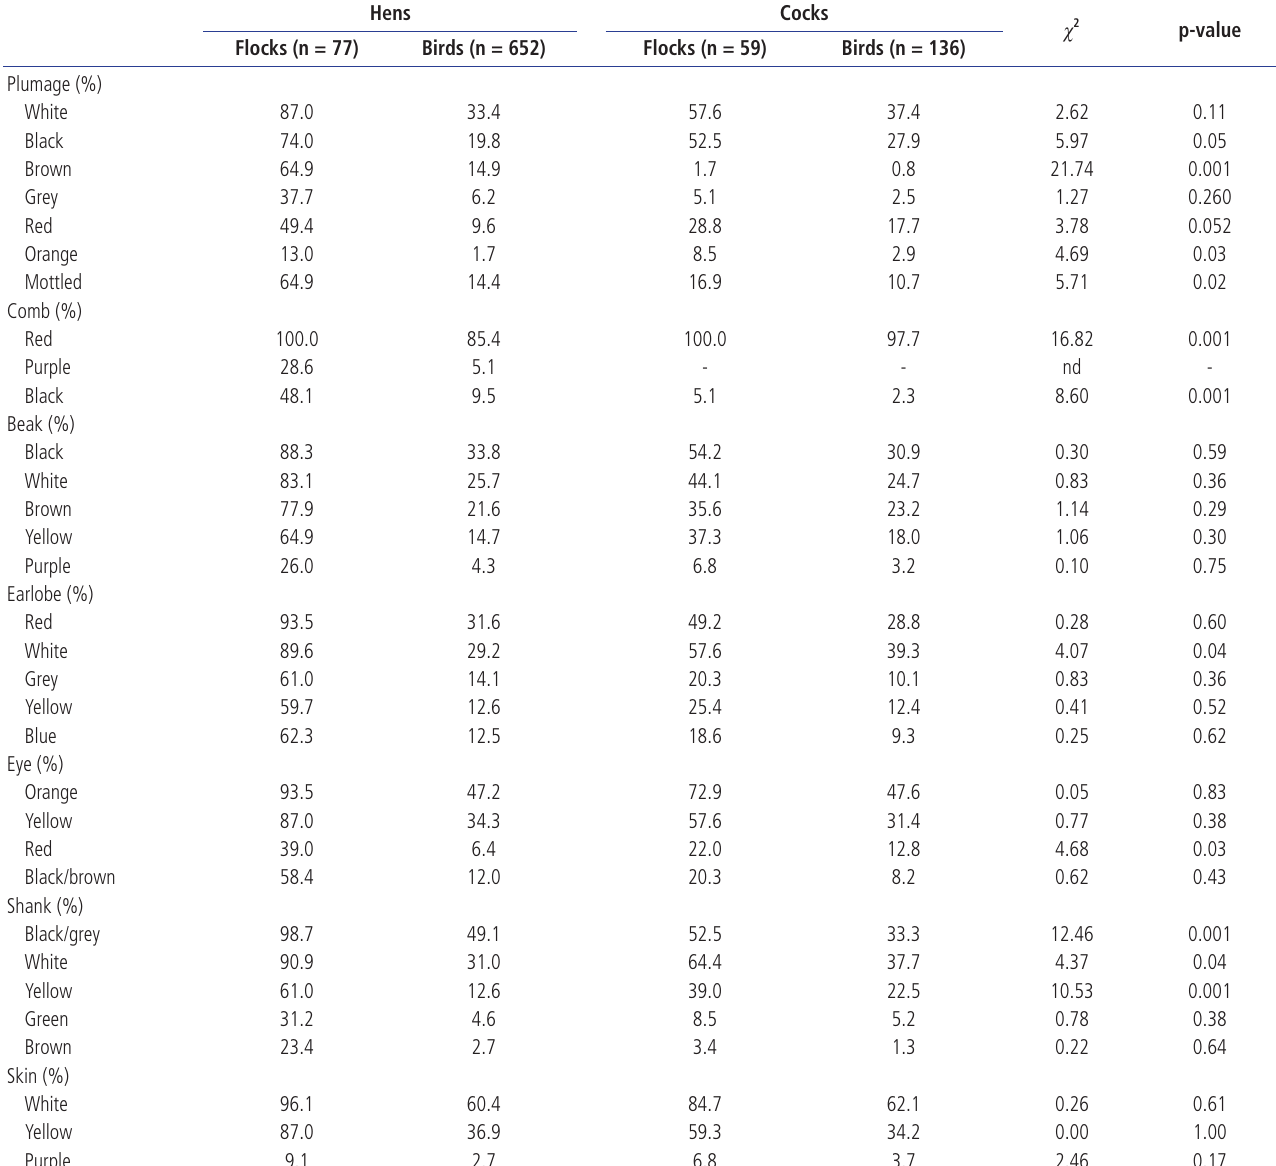
Table 2. Color distributions of local chickens in individual household flocks